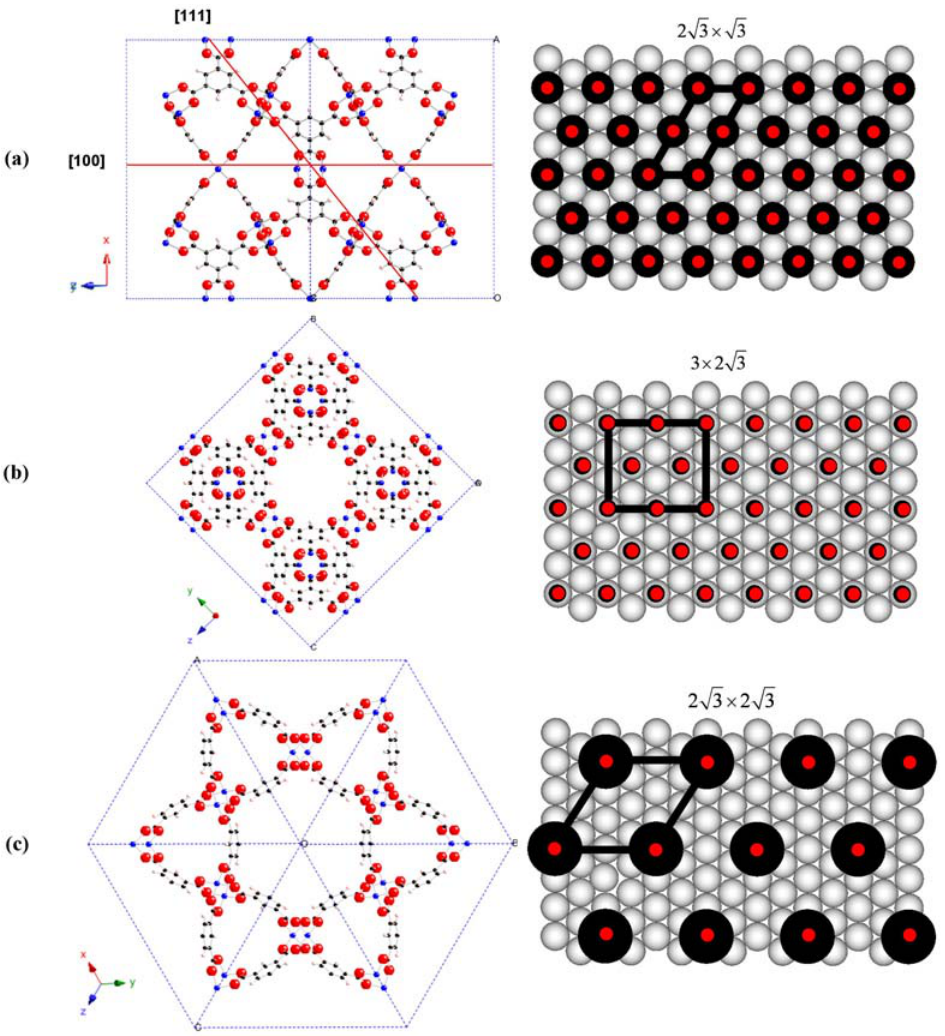
Figure 3. [Cu (btc) ] (HKUST-1) metal-organic framework. The blue dashed line makes 3 2 n the unit cell; the bold red lines indicate the proposed contact planes between the SURMOF and the SAM. The black solid circles indicate the alkane and triptycene chains of the mercaptohexadecanoic acid (MHDA)- and 9-carboxy-10-(mercaptomethyl)triptycene (CMMT)-SAMs, respectively. The red solid circles indicate assumed positions of the carboxyl groups in the MHDA-, 4’-carboxyterphenyl-4-methanethiol (TPMTA)- and CMMT-SAMs, respectively. ( a ) Side view of the (100) and (111) planes and the overlayer structure of TPMTA-SAM; ( b ) top view of the (100) plane and the overlayer structure of MHDA-SAM; ( c ) top view of the (111) plane and the overlayer structure of